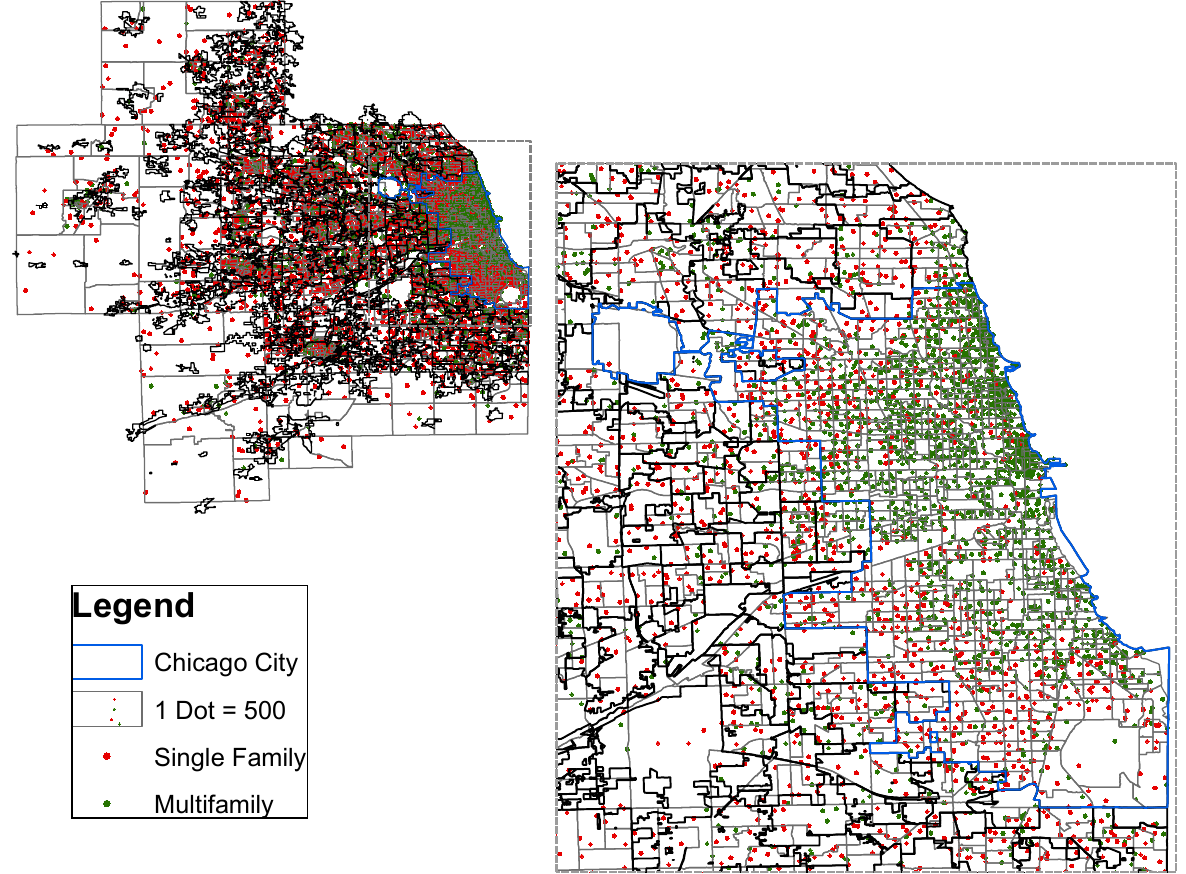
Figure 4: Single-family and multifamily housing units in the Chicago metropolitan area, 2014 Turning to segregation by housing costs, segregation by rent and by home values declined—high- and low-cost housing was distributed more equally between places and between central cities and suburbs from 1990 to 2014 (top panel).